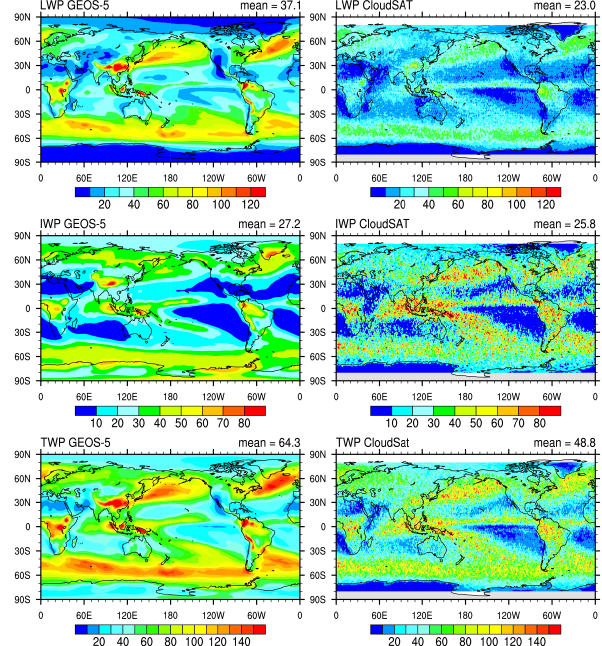
Figure 10. Liquid (LWP), ice (IWP), and total (TWP) water paths (gm − 2 ) for non-convective, non-precipitating clouds from GEOS-5 output using the new microphysics and from the CloudSat retrieval (Li et al., 2012,